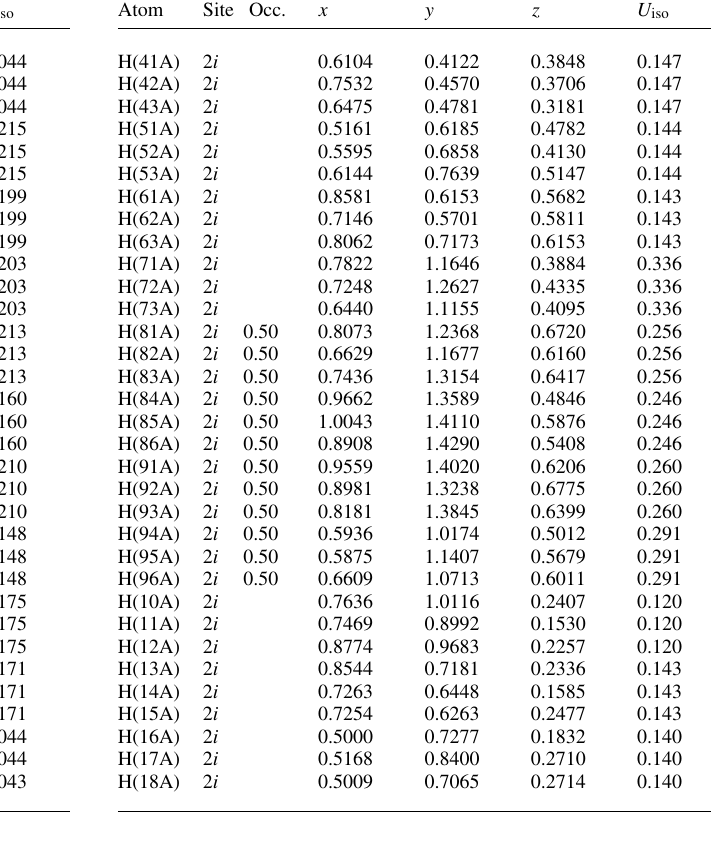
Table 2. Atomic coordinates and displacement parameters (in Å 2 ) . Atom Site